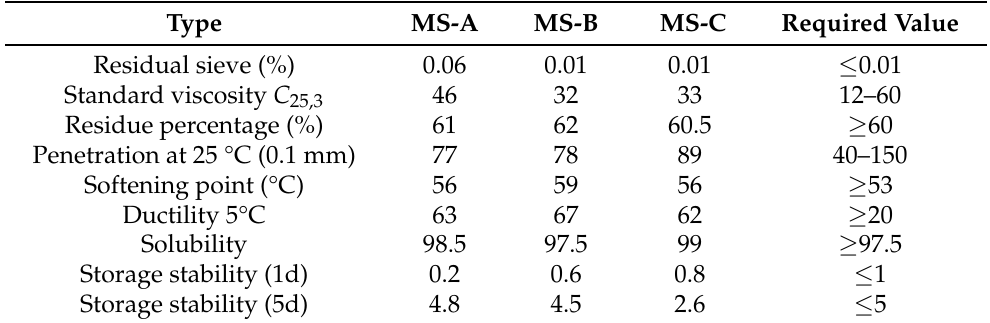
Table 1. Properties of emulsion